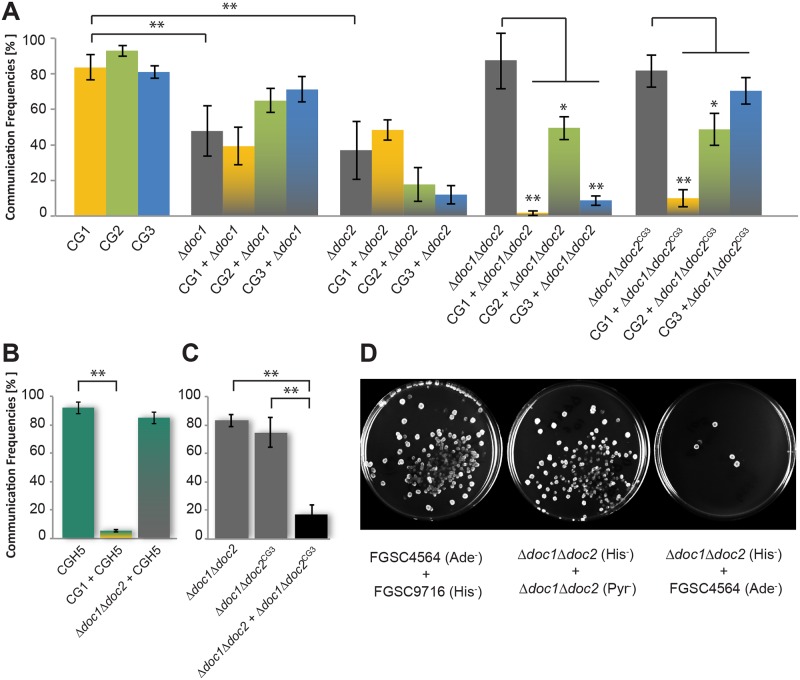
Communication interactions of Δdoc-1, Δdoc-2, Δdoc-1 Δdoc-2, and Δdoc-1 Δdoc-2 (his-3::doc-1
CG3
doc-2
CG3) germlings.(A) Self-communication and non-self-communication frequencies between germlings of different mutants and the communication group tester strains. One-color bars denote self-communication frequencies between genetically identical germlings from a single strain, while two-color bars denote communication frequencies between genetically different germlings. Δdoc1Δdoc2
CG3 denotes Δdoc-1 Δdoc-2 (his-3::doc-1
CG3
doc-2
CG3). CG tester strains were FGSC 2489, CG1; JW262, CG2; P4483, CG3. (B) Self-communication frequencies of CGH5 germlings (JW220) and non-self-communication frequencies of CGH5 germlings with CG1 (FGSC 2489) germlings (CG1 + CGH5), which show very low communication frequency. In contrast, Δdoc-1 Δdoc-2 germlings (deletion strain derived from FGSC 2489) show high communication frequencies with a CGH5 strain (JW220) (Δdoc-1 Δdoc-2 + CGH5). (C) Self-communication frequencies of Δdoc-1 Δdoc-2 germlings (left grey bar), self-communication frequencies of Δdoc-1 Δdoc-2 (his-3::doc-1
CG3
doc-2
CG3) germlings (right grey bar), and non-self-communication frequencies of Δdoc-1 Δdoc-2 (his-3::doc-1
CG3
doc-2
CG3) germlings with Δdoc-1 Δdoc-2 germlings (right bar). Δdoc1Δdoc2
CG3 denotes Δdoc-1 Δdoc-2 (his-3::doc-1
CG3
doc-2
CG3). Experiments for A, B, and C were performed in triplicate with at least 100 germling pairs counted for each experiment. Black bars indicate standard deviations (Student's t test, *: p < 0.05, **: p < 0.01; see S1 Data for numerical values). (D) Quantitative heterokaryon test, in which conidia of CG1 strains with complementary auxotrophic markers (FGSC 4564; ad-3B + FGSC 9716; his-3), or conidia from Δdoc-1 Δdoc-2 strains with complementary auxotrophic markers (Δdoc-1 Δdoc-2; his-3 + Δdoc-1 Δdoc-2; pyr-4) or conidia from a CG1 strain and a Δdoc-1 Δdoc-2 strain with complementary auxotrophic markers (FGSC 4564; ad-3B + Δdoc-1 Δdoc-2; his-3) were mixed and spread on modified VMM agar plates (see Materials and Methods for details). Colonies form only if germlings/hyphae containing complementary auxotrophic markers undergo fusion to form a prototrophic heterokaryon. Images show the results of one out of three experiments (see S4E Fig for quantitative data).